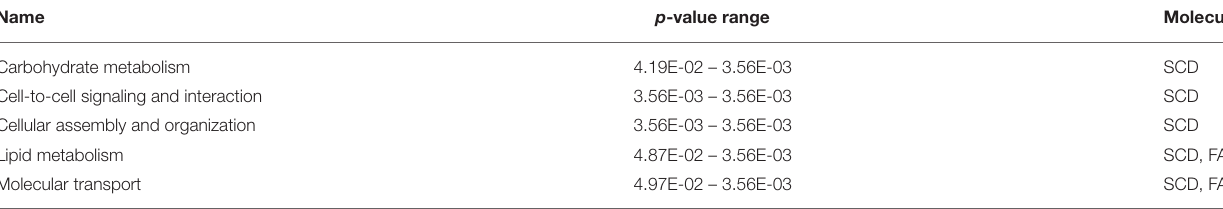
TABLE 7 | Molecular and cellular functions between Phb1 + / − and WT.